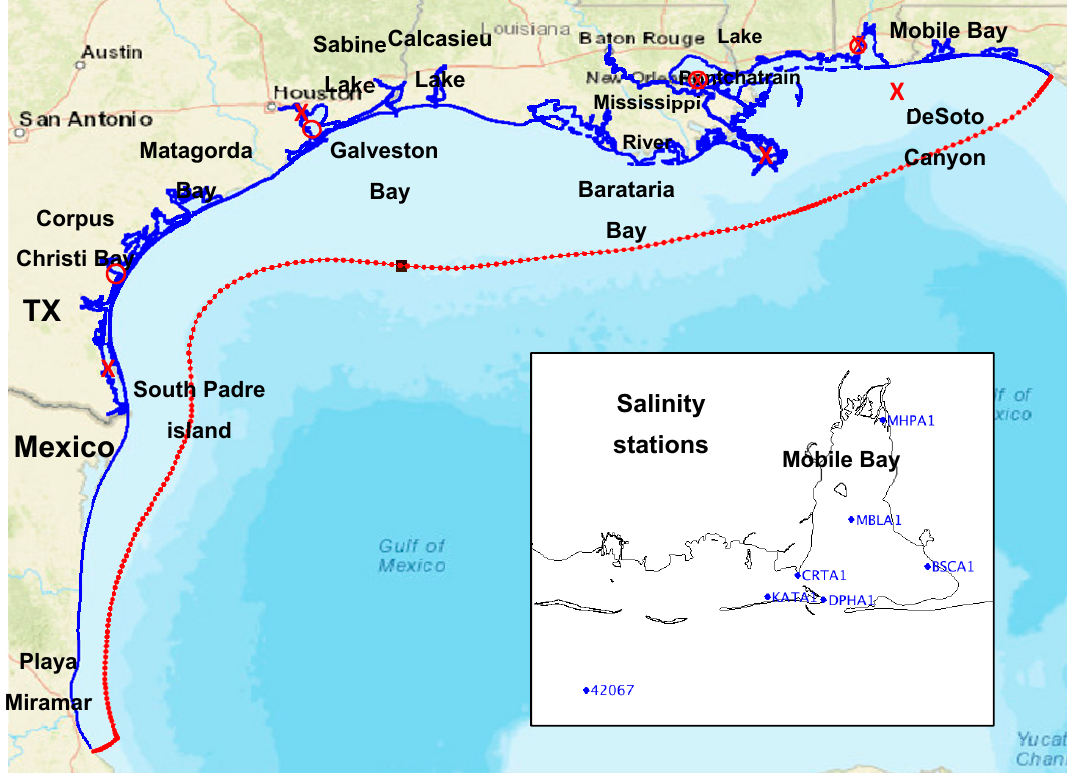
Figure 1. Map of northern Gulf of Mexico. Blue and red lines combine to delineate the INGOFS model grid boundary. The red line represents the model’s open ocean boundary. Marked are the water level (WL) (o) and the sea-surface temperature (SST) stations (x) (Section 4). The inset displays the salinity stations (Section 4). From west to east are shown the WL stations 8735391, 8761927, 8771013, and 8775792; and the SST stations 42012, MCGA1, NWCL1, PILL1, MGPT2, and PMNT2.